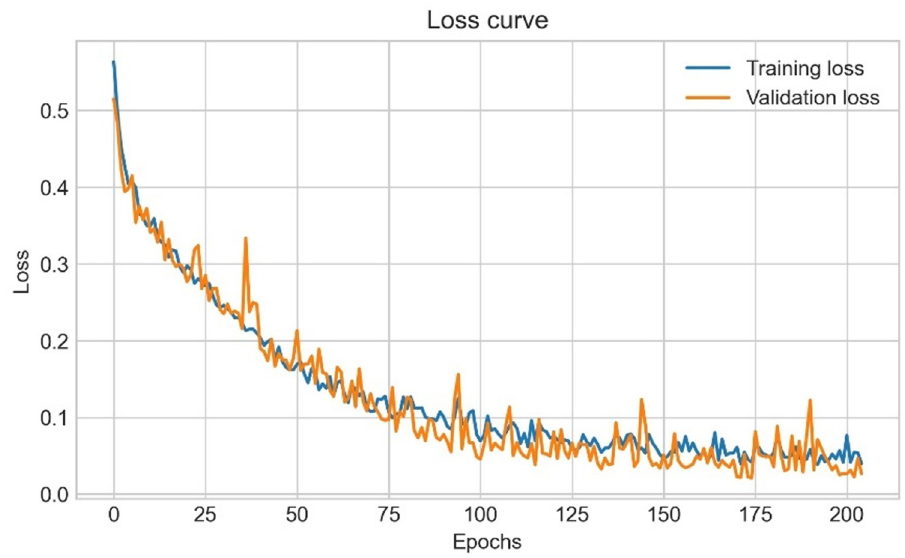
Fig 24. Training and validation loss curve of 200 epochs for Adam with learning rate 0.001.